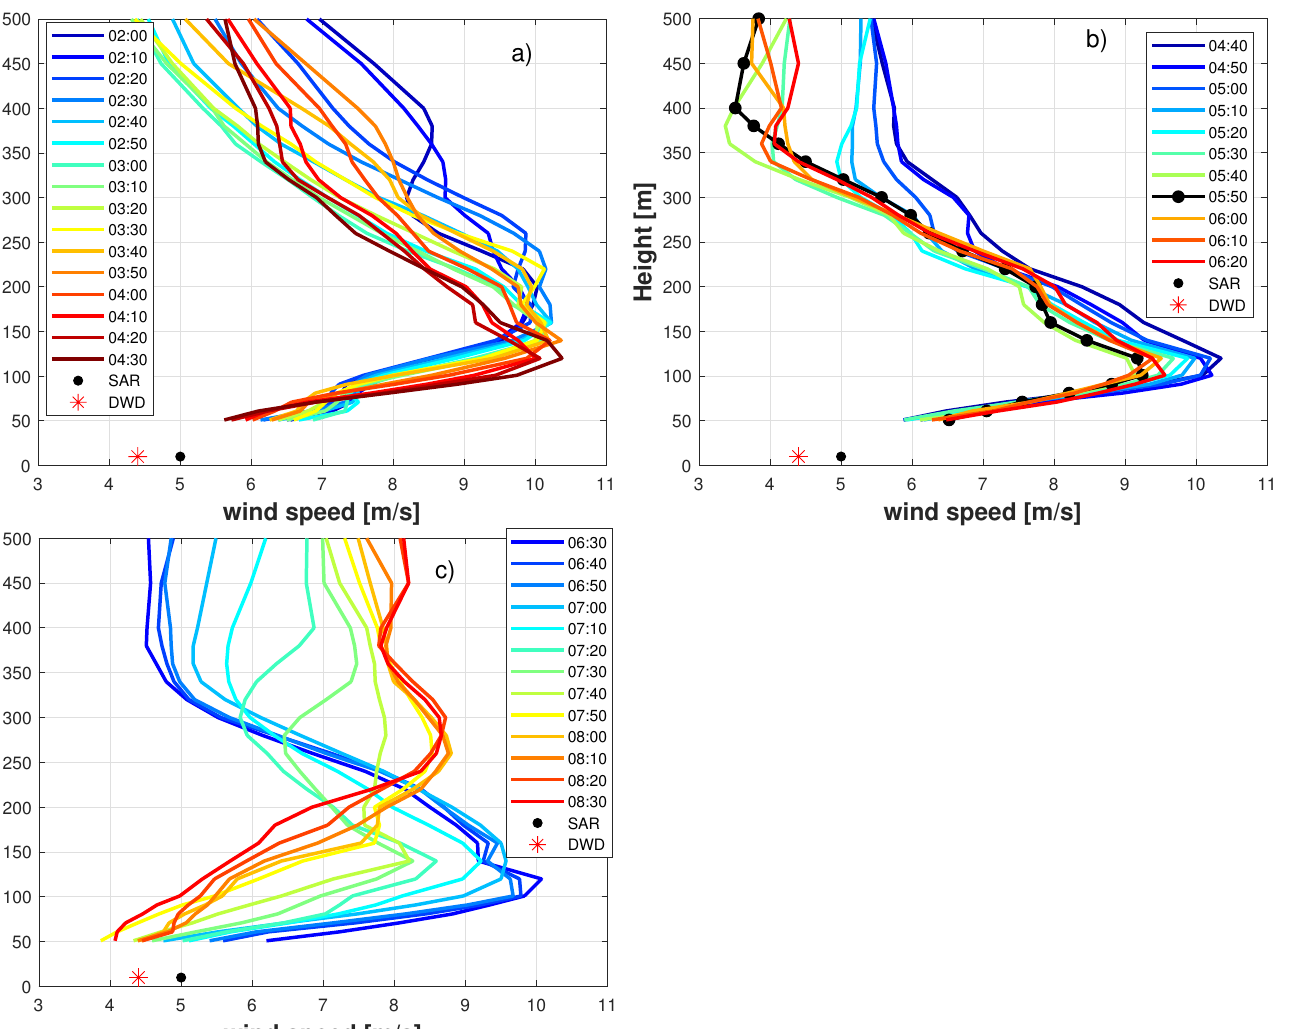
(Figure 8a), decreasing to 120 m around SAR acquisition time (Figure 8b). The jet is spread over a wider altitude band after 6:30UTC and finally starts to disappear around 8:00UTC (Figure 8c). This phenomenon is found to have a high frequency of occurrence between evening and morning at these latitudes [54].